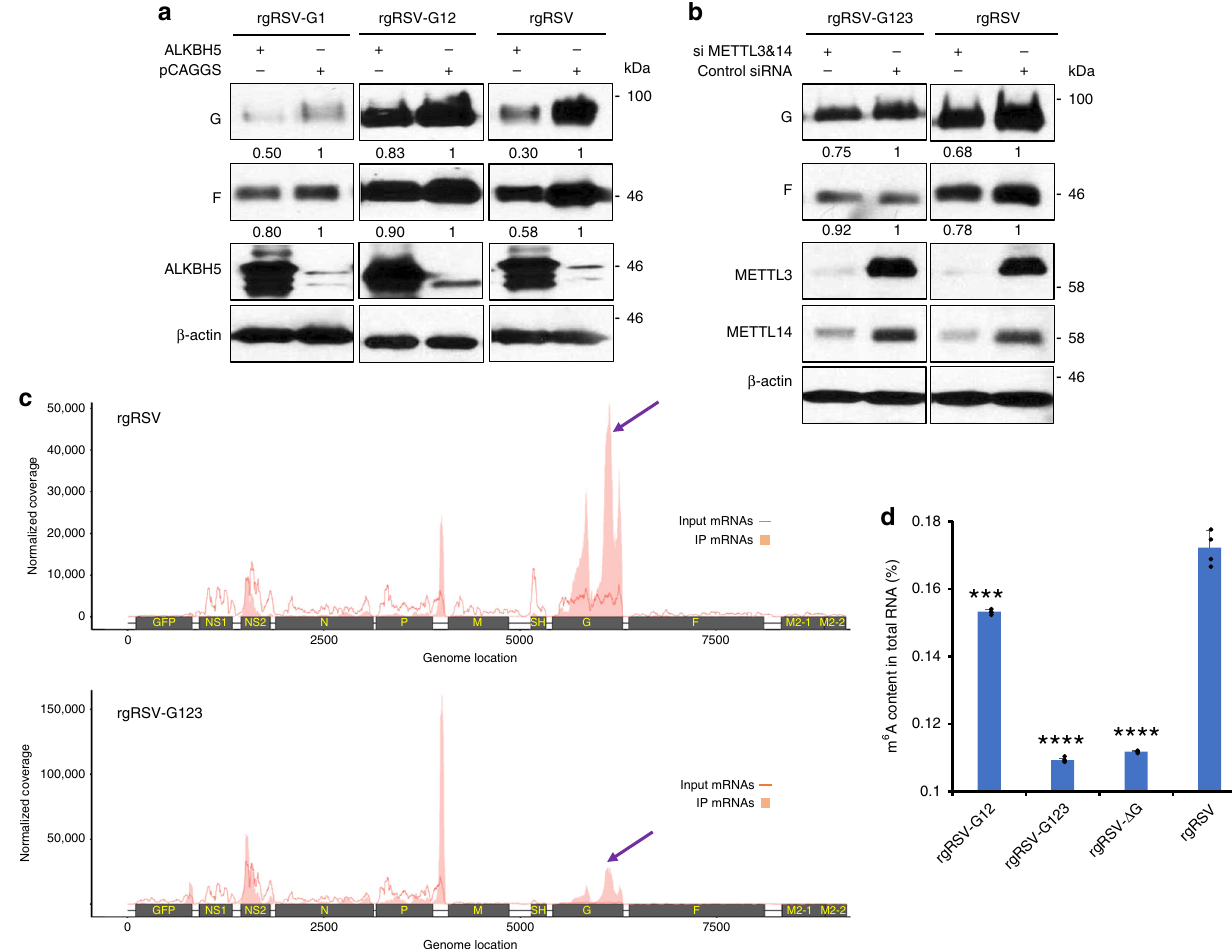
Fig. 10 The attenuated phenotype of m 6 A mutated rgRSVs is m 6 A-related. a rgRSV-G1 and -G12 were less dependent on the m 6 A eraser protein. A549 cells were transfected with a plasmid encoding ALKBH5. At 36 h post-transfection, cells were infected with each rgRSV at an MOI of 0.5. At 18 h post- infection, cell lysates were harvested for western blot analysis. Western blot images are the representatives of three experiments. b rgRSV-G123 expression was less dependent on m 6 A writer protein. A549 cells were transfected with control siRNA or siRNA targeting METTL3 and METTL14. At 36 h post-transfection, cells were infected with each rgRSV at an MOI of 0.5. At 18 h post-infection, cell lysates were harvested for western blot analysis. The density of western blot was quanti fi ed by Image J software, and the ratio of the protein bands was calculated. Images are the representatives of three experiments. c Distribution of m 6 A peaks on the RSV mRNAs from A549 cells infected by rgRSV and rgRSV-G123. Con fl uent A549 cells were infected by each m 6 A-mutated rgRSV at an MOI of 1.0, cell lysates were harvested at 36 h post-infection. Total RNAs were extracted from cell lysates, and were enriched for mRNA by binding to oligo dT, and subjected to m 6 A-seq. The distribution of m 6 A-immunoprecipitated (IP) reads were mapped to the RSV mRNAs (pink block). The baseline distributions for mRNAs from input sample are shown as a pink line. Data presented are the mean coverage from two independent virus-infected A549 cell samples ( n = 2). Red arrow indicates the m 6 A enrichment in G mRNA. d Virion RNA of m 6 A-mutated rgRSVs is defective in binding to anti-m 6 A antibody. Virion RNA was extracted from highly puri fi ed RSV virions. Antigenome was quanti fi ed by real-time RT-PCR. Each amount of antigenome was bound to strip wells using a RNA high binding solution, and m 6 A was detected using a speci fi c capture anti-m 6 A antibody and then quanti fi ed colorimetrically by reading the absorbance in a microplate spectrophotometer at a wavelength of 450 nm. A standard curve was generated using known m 6 A methylated RNA (range from 0.02 to 1 ng of m 6 A) as a positive control. The m 6 A content was calculated from each RNA samples. Data are averages of four independent experiments. The P value (Student ’ s t -test) for rgRSV-G12, rgRSV-G123, and rgRSV- Δ G is *** P = 0.000325, **** P = 3.09 × 10 − 7 , and **** P = 3.74 × 10 − 7 , respectively